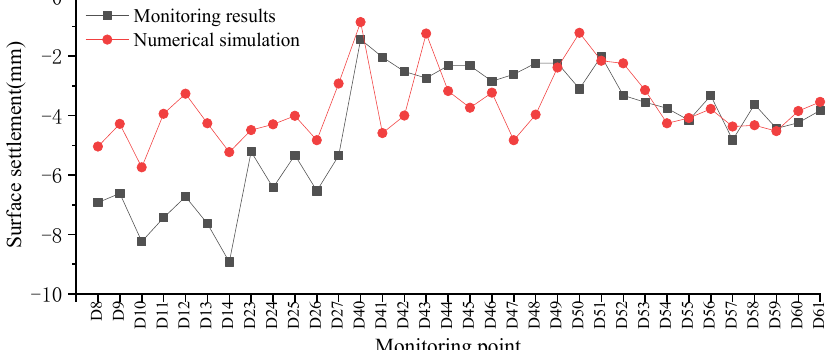
Figure 27. Comparison of surface settlement.